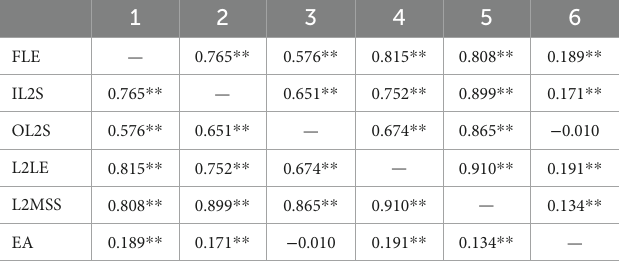
TABLE 4 Correlation analyses on FLE, L2MSS, and English